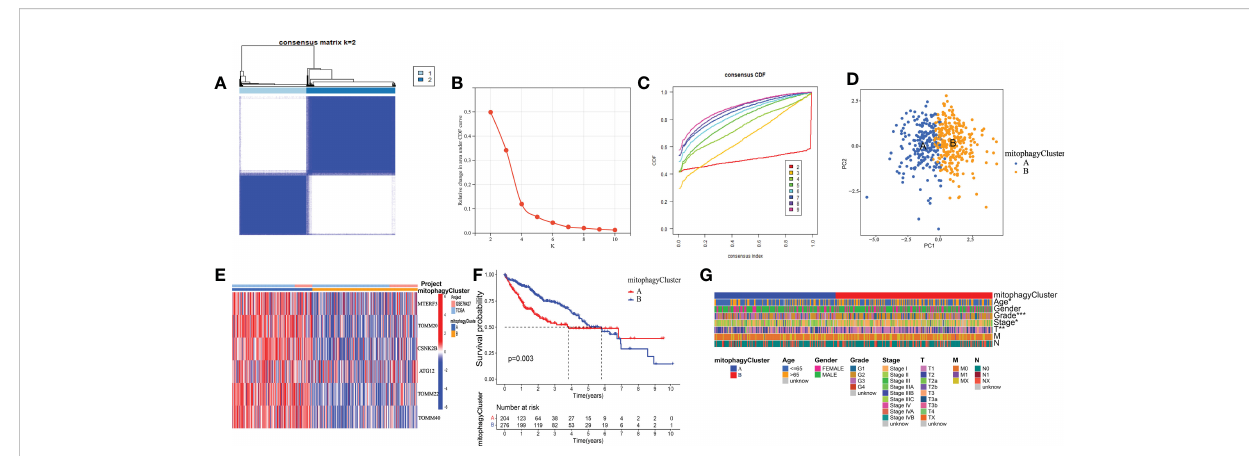
FIGURE 4 The prognostic value of the cluster A and cluster B. (A) Consensus matrix identi fi ed two clusters. (B) Delta area of the cluster analysis. (C) The cumulative distribution function of the cluster. (D) PCA indicated two components. (E) Transcription pro fi le heatmap of six mitophagy genes in cluster A and cluster B. (F) Kaplan – Meier analysis of OS. (G) Clinical relevance of cluster A and cluster B in TCGA-HCC cohort. The asterisks represented the statistical P-value (*P < 0.05; **P < 0.01; ***P <